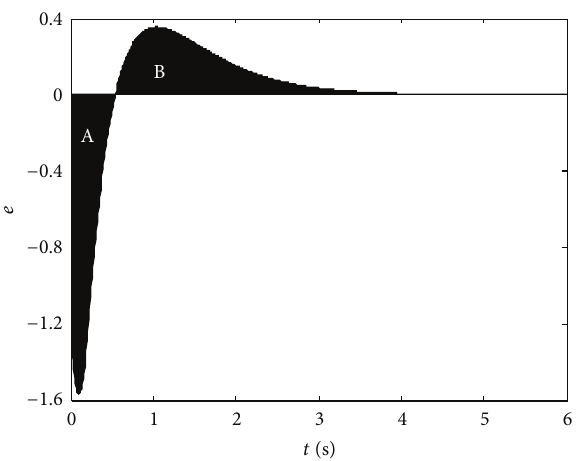
Figure 7: Curve of tracking error (controller